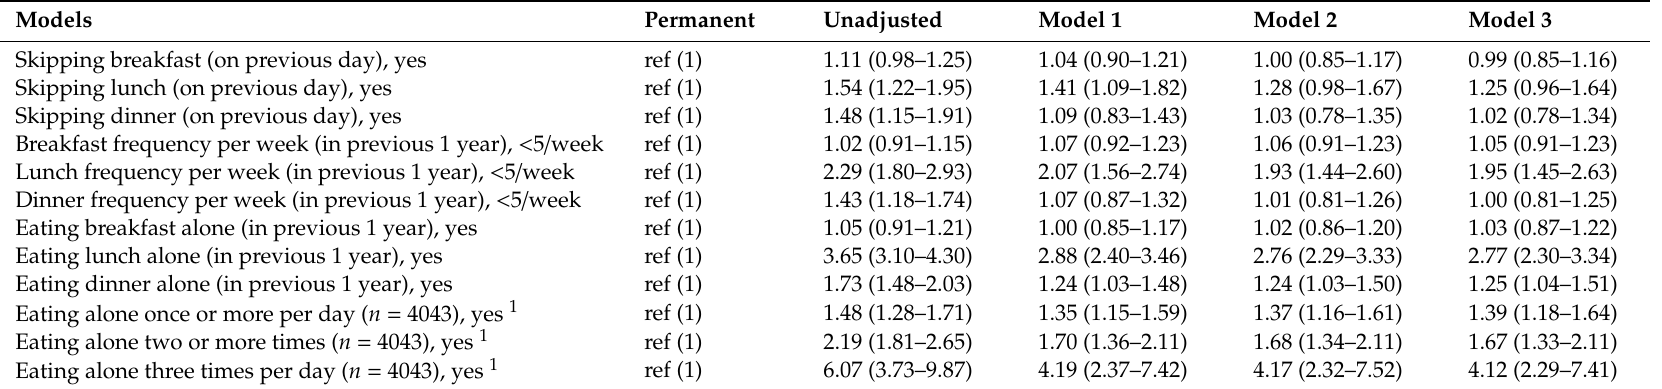
Table 3. Odds ratios (95% CI) of eating behaviors for temporary workers ( n =